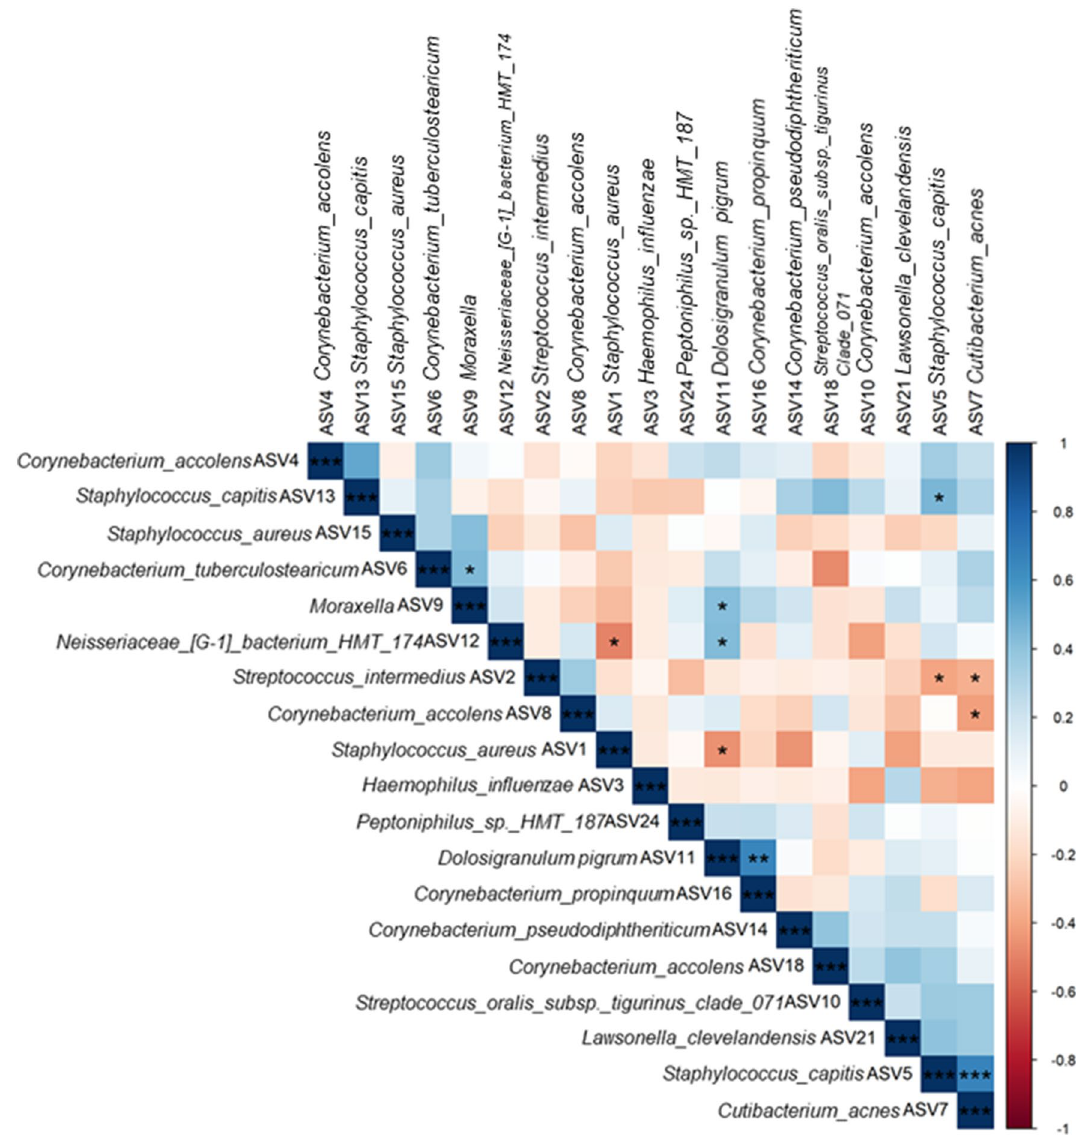
Figure 2. Spearman correlations displayed as a heatmap between taxonomy-assigned amplicon sequence variants (ASV) from bacterial community 16S rRNA gene amplicon sequence data. Both positive and negative correlations between bacterial ASVs were calculated from ASVs with more than 1% total relative abundance across all samples. Significance levels after “BH” p -value correction for multiple pairwise comparisons are displayed on the heatmap. *** p < 0.001, ** p < 0.01, * p < 0.05. Spearman correlations were calculated in the R statistical program 3.6.1 package ‘corrplot’ and heatmaps were visualised using ‘ggplot2’ version